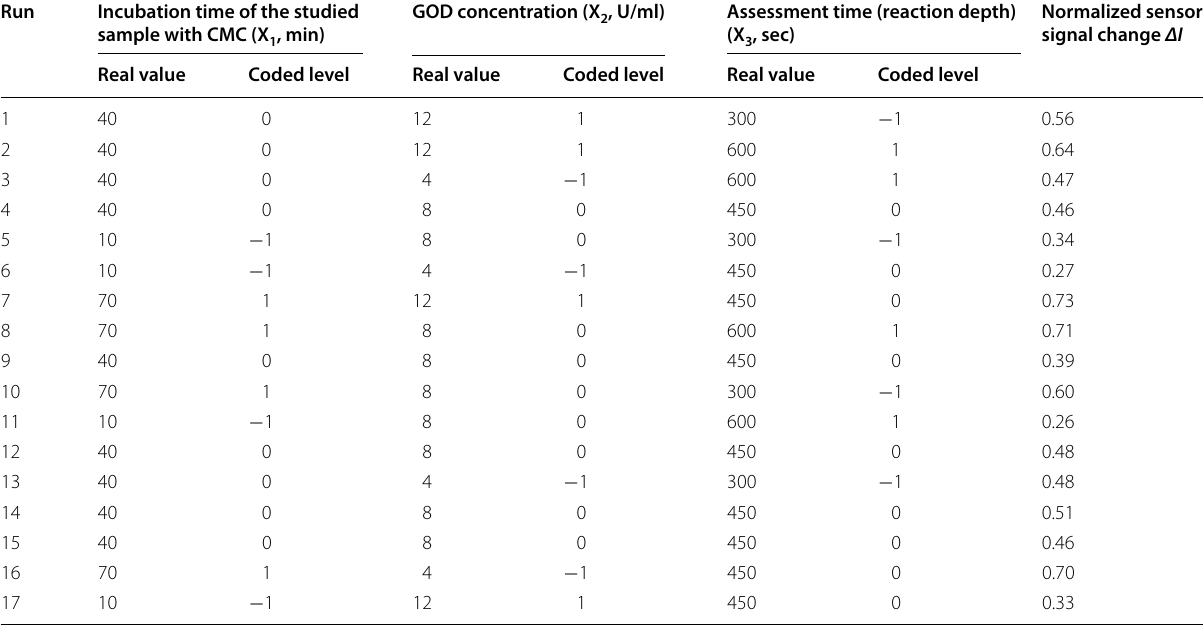
Table 1 Box-Behnken experimental design and response values for normalized output signal change